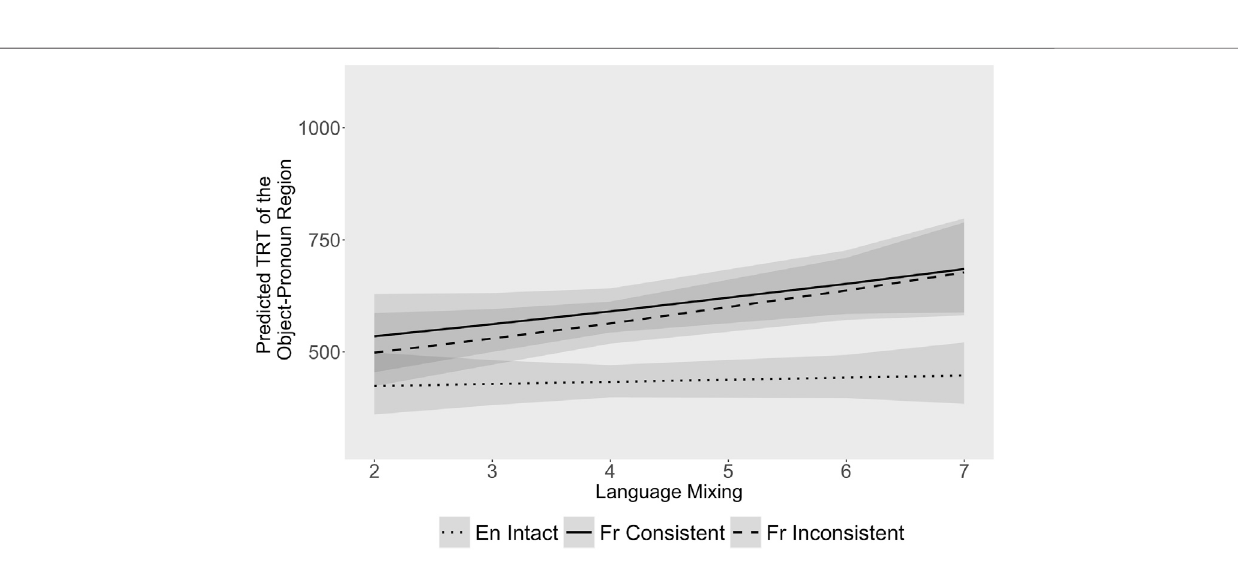
Frontiers in Communication |